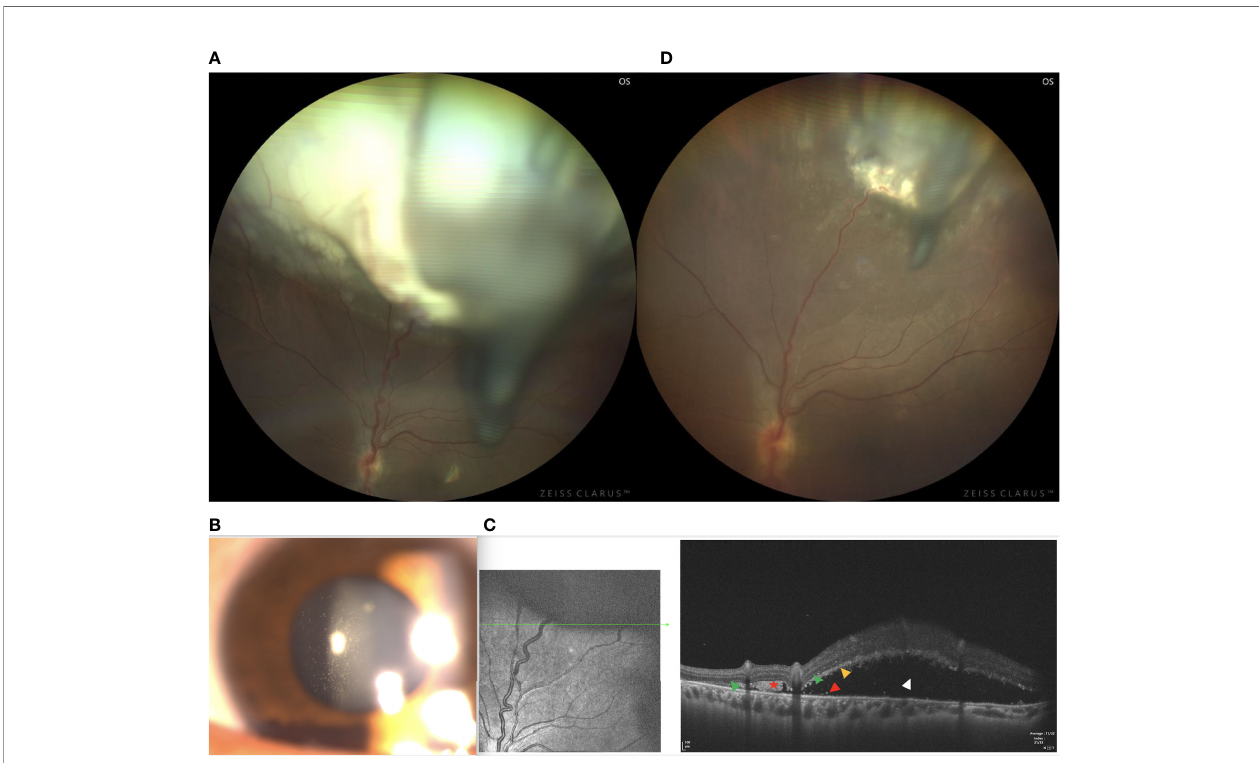
FIGURE 6 | (A) In patient 6, there was a white, circumscribed lesion of the retina in the superotemporal peripheral fundus, with tortious seeding vessels, retinal exudation, and subretinal fl uid in the left fundus. Signi fi cant vitreous seeds were observed. (B) The slit lamp microscope showed signi fi cant tumor seeds fl oating in the vitreous cavity. (C) The SS-OCT B-scan revealed local exudative retinal detachment surrounding the tumor, as well as subretinal deposition spots with medium to high re fl ectivity without involving the macular. (Green Triangle: outer limiting membrane; Red Pentagram: tumor cell cluster; Yellow triangle: damaged photoreceptor cell layer and suspended tumor cells; Red triangle: discrete subretinal tumor cells; Blue triangle: tumor cells are implanted in the vitreous cavity; White triangle: super fi cial retinal detachment) (D) Three months after I-125 plaque brachytherapy, the tumor showed a reduction in size, resolution of subretinal fl uid, normalization of the caliber and decrease in the tortuosity of feeding and draining